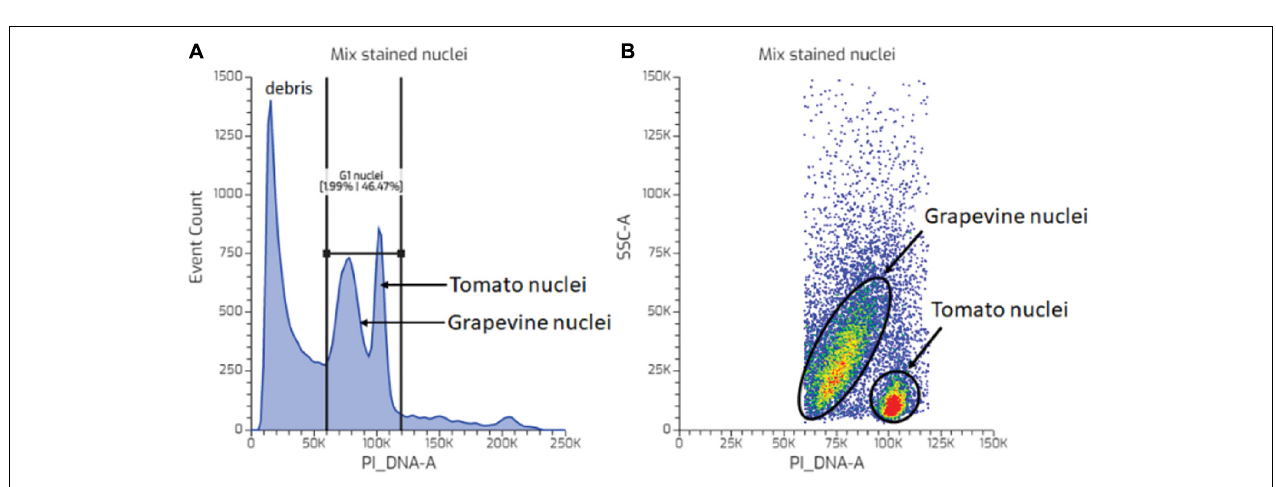
FIGURE 3 | Nuclei complexity analysis. (A) PI-stained events of a mixed nuclei suspension sample of grapevine bud and tomato leaf. (B) Optical complexity of tomato and grapevine bud nuclei from the gated PI nuclei events in (A) . Colors in dot plot indicate nuclei population density, being red as the highest and blue the